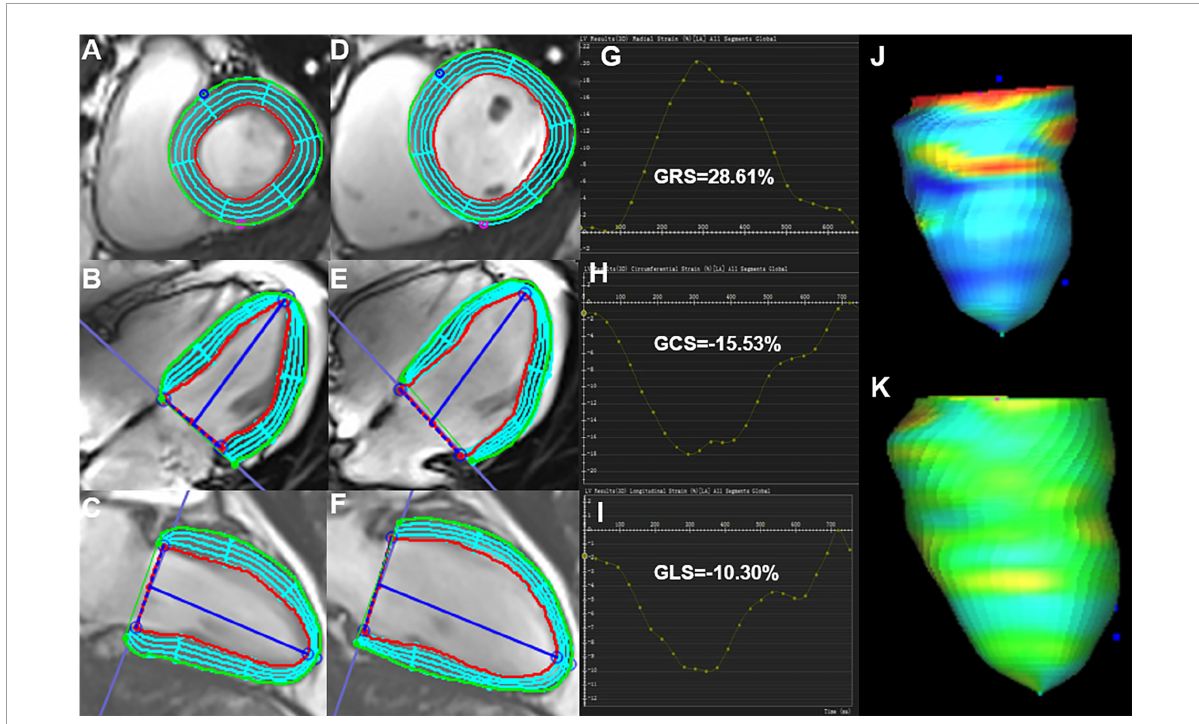
FIGURE1 Cardiac magnetic resonance feature-tracking technology on cvi42 for the analysis of the LV strain. Manual drawing of the endocardium and epicardium of the LV at the end-systolic (A–C) and end-diastolic (D–F) phases. Then, the software automatically traced each voxel of the myocardium and calculated the LV strain parameters. (G–I) Measurement of the LV global peak strain parameters: GRS of 28.61%, GCS of − 15.53%, and GLS of − 10.31% were obtained. (J,K) 3D pseudo-color images for the LV end-systolic/end-diastolic GLS. LV, left ventricle; GRS, global radial peak strain; GLS, global longitudinal peak strain; GCS, global circumferential peak